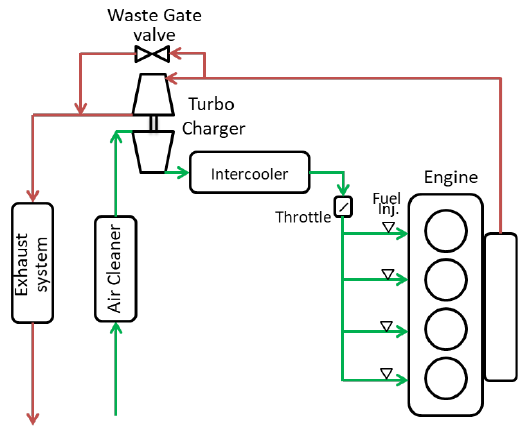
Figure 1. Schematic layout of the engine [25].